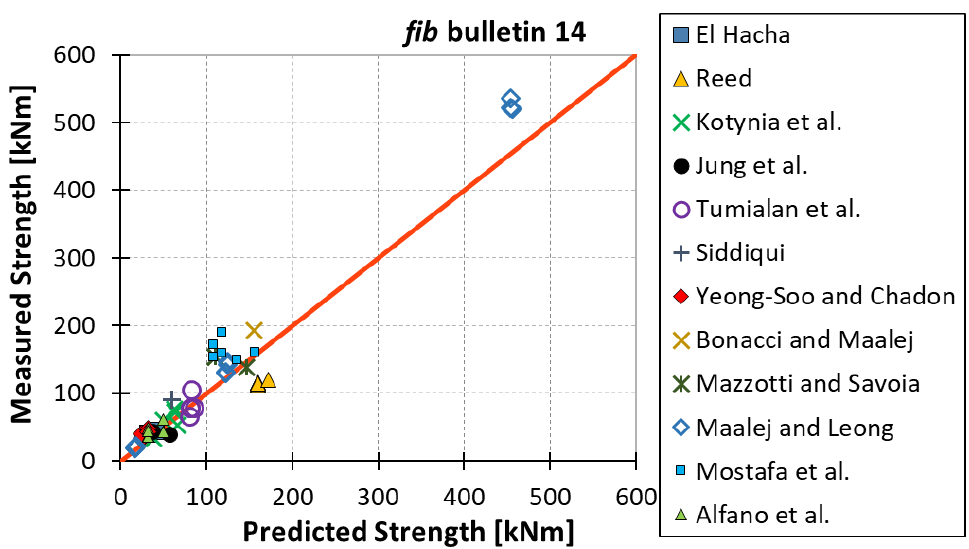
Figure 4. Measured flexural strength versus fib bulletin 14 prediction.